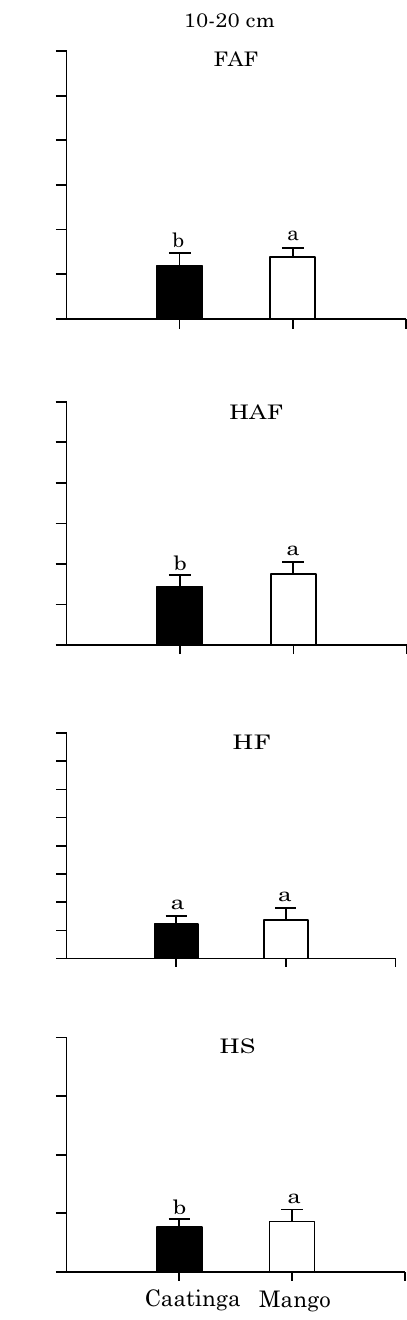
Figure 3. Carbon stocks in the fulvic acid fraction (FAF), humic acid fraction (HAF), humin fraction (HF), and humic substances (hs) in the 0-10 and 10-20 cm soil layers under irrigated mango and native caatinga . Columns designated by the same letter do not differ by the Student t test (α = 5 %). The vertical deviation bars represent the standard deviation of the